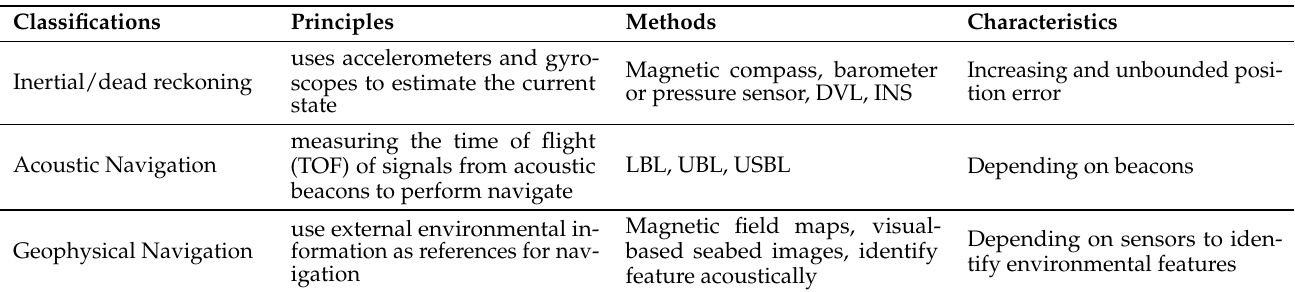
Table 2. Three main categories of underwater navigations